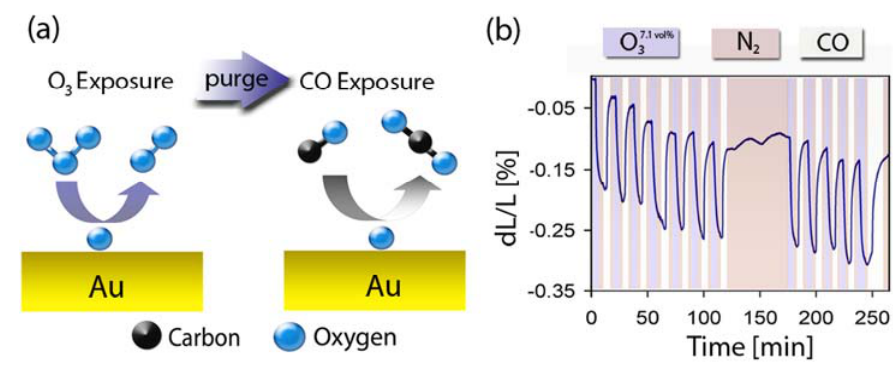
Figure 7. Illustration of surface chemistry driven actuation in nanoporous gold. (a) The surface of np-Au can be switched back and forth between an oxygen-covered and clean state by alternating exposure to ozone (O time as the np-Au actuator is alternately exposed to a mixture of ~7 vol % O pure CO. Ozone exposure causes contraction, while CO exposure restores the original sample dimension. Reproduced from Ref.